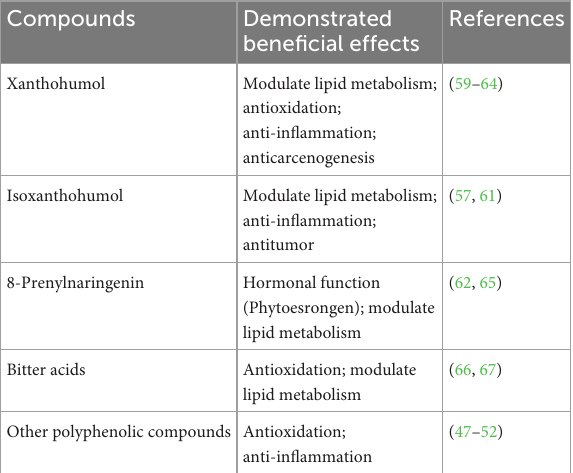
TABLE 1 Bioactive flavor compounds in beer and their beneficial